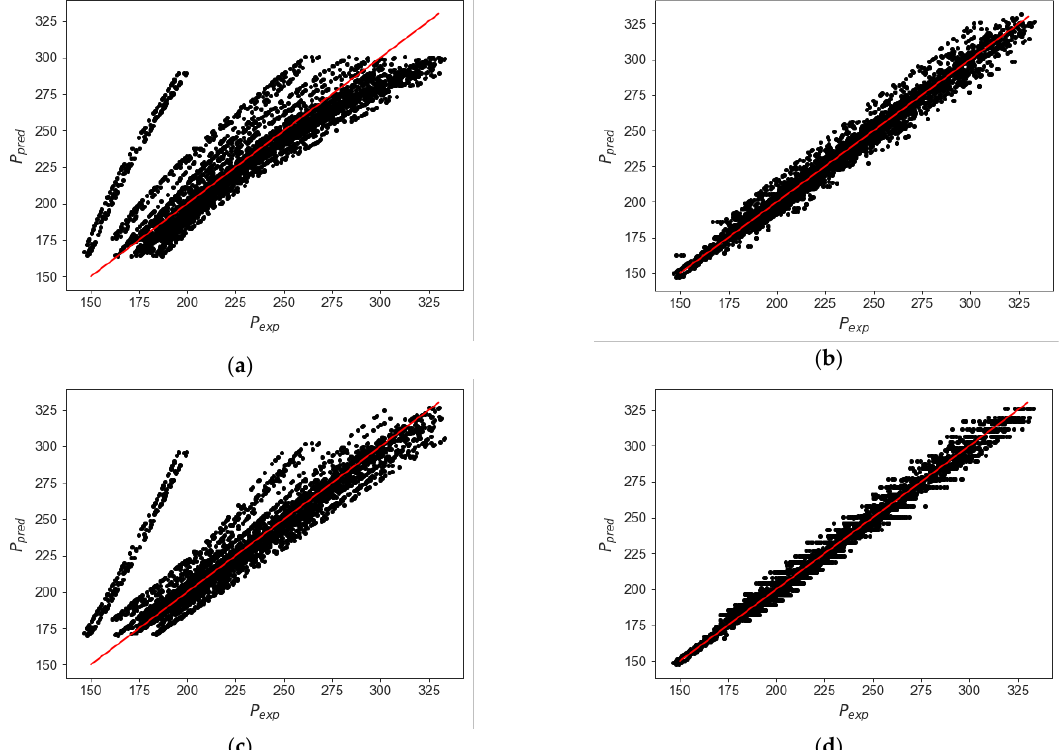
Figure 21. Test pressure vs. calculated pressure for the different models are as follows: ( a ) linear regression, ( b ) KNN, ( c ) SVC, and ( d ) decision tree regressor. Note: red line represents a perfect prediction.